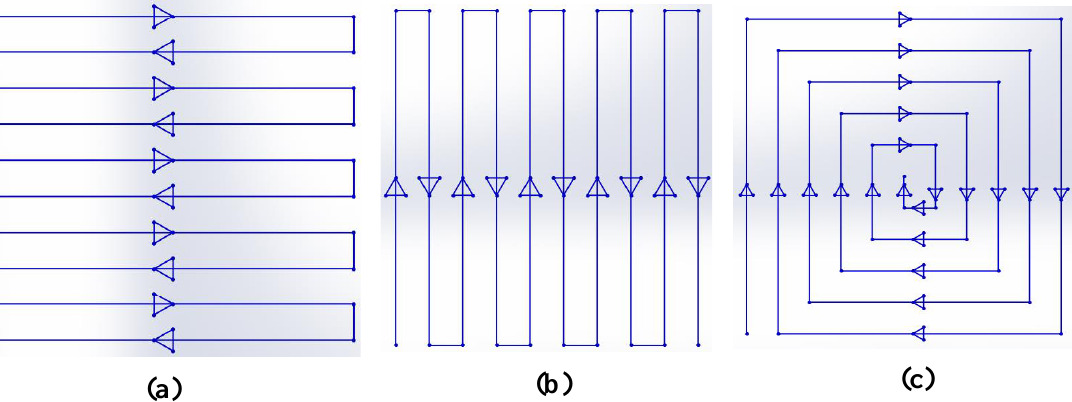
Figure 1. Three scan strategies used in this study. ( a ) Z-shape scan strategy vertical to the inner structure; ( b ) Z-shape scan strategy along the inner structure; ( c ) square-framed scan strategy.